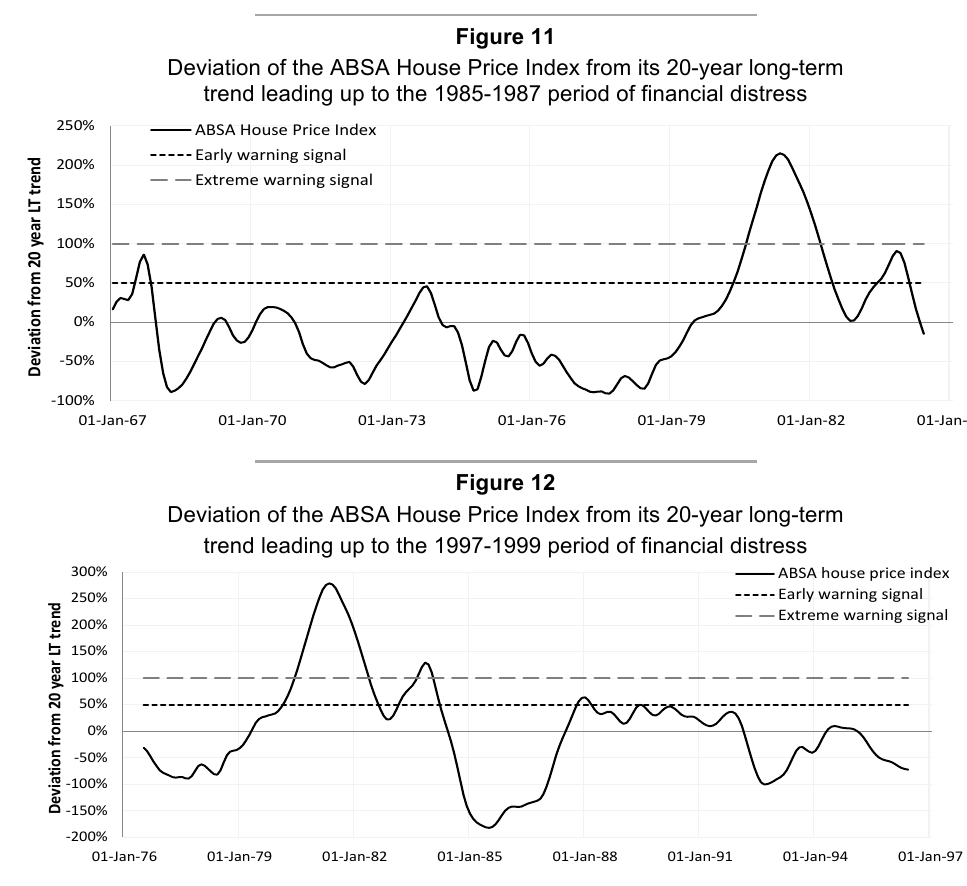
up of systemic risk. The next early warning signal came in the first quarter of 2003. The extreme warning level was breached at the beginning of 2004 for the first time, peaking in October 2004, four years ahead of the crisis.